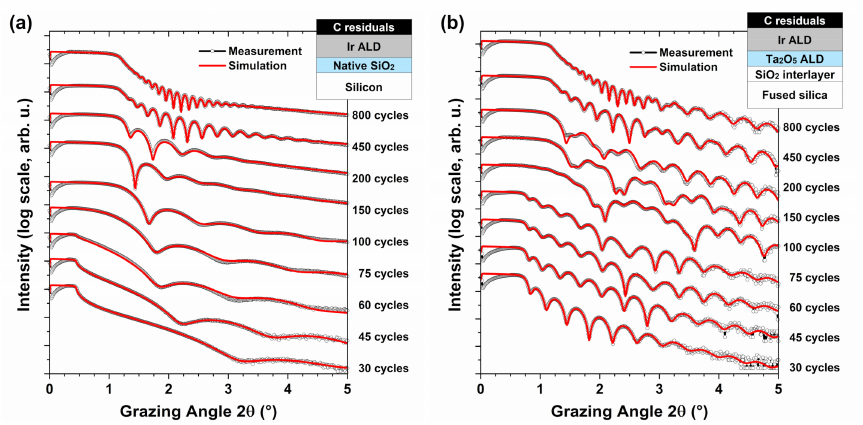
Figure 3. X-ray reflectivity (XRR) measurements (black) with corresponding simulation (red) of Ir coatings with different numbers of ALD cycles on ( a ) Si wafers and ( b ) Ta 2 O 5 seed layers deposited on fused silica. Diffractograms are vertically shifted for clarity. In the upper right corner, the applied layer models for fitting the data are shown graphically, not true to